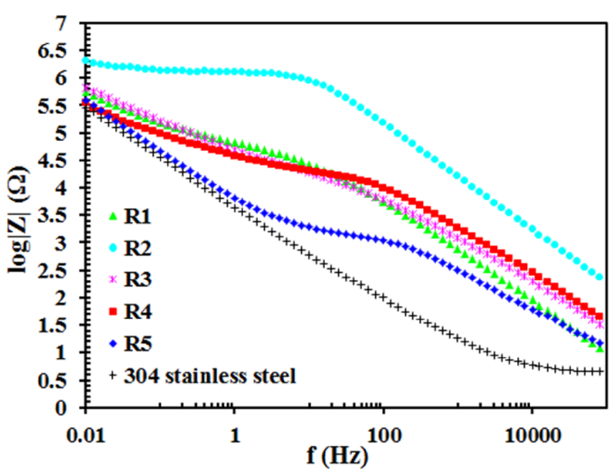
Figure 6. Bode plots (impedance modulus vs. frequency) of 304 stainless steel and samples R1–5. Electrochemical impedance spectroscopy analysis allows matching electric equivalent circuits (EEC) to the tested electrochemical systems [39,40]. Figure 7 shows Nyquist plots. The symbols used to stand for the experimental data, while the lines stand for the data obtained as a result of EEC fitting. The degree of agreement between the lines and the experimental points informs about the correctness of the choice of EEC. Figure 8a–c shows the EEC that were fitted to the EIS test results of unmodified 304 stainless steel and samples R1–5. The elements constituting the presented circuits are resistors (R), constant phase element parameters (Q) and di ff usion element (M): R s : uncompensated